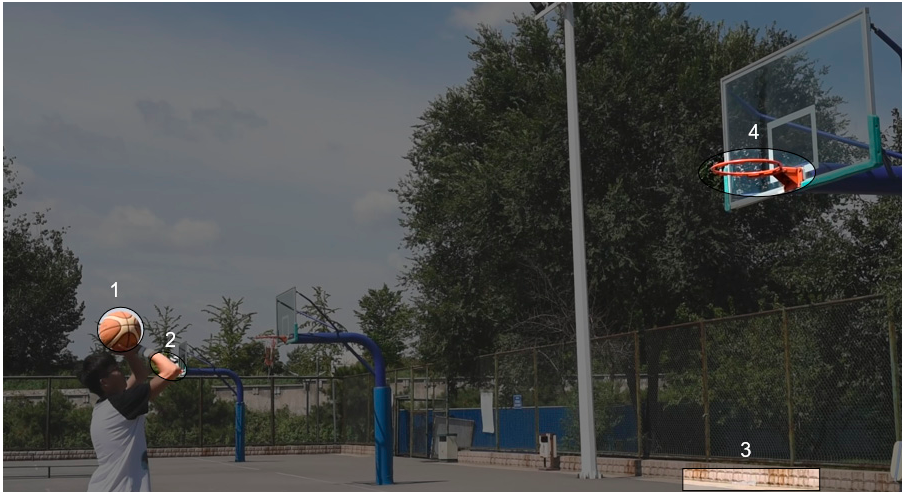
Figure 5. The shot image after constructing the red channel and opening operation.